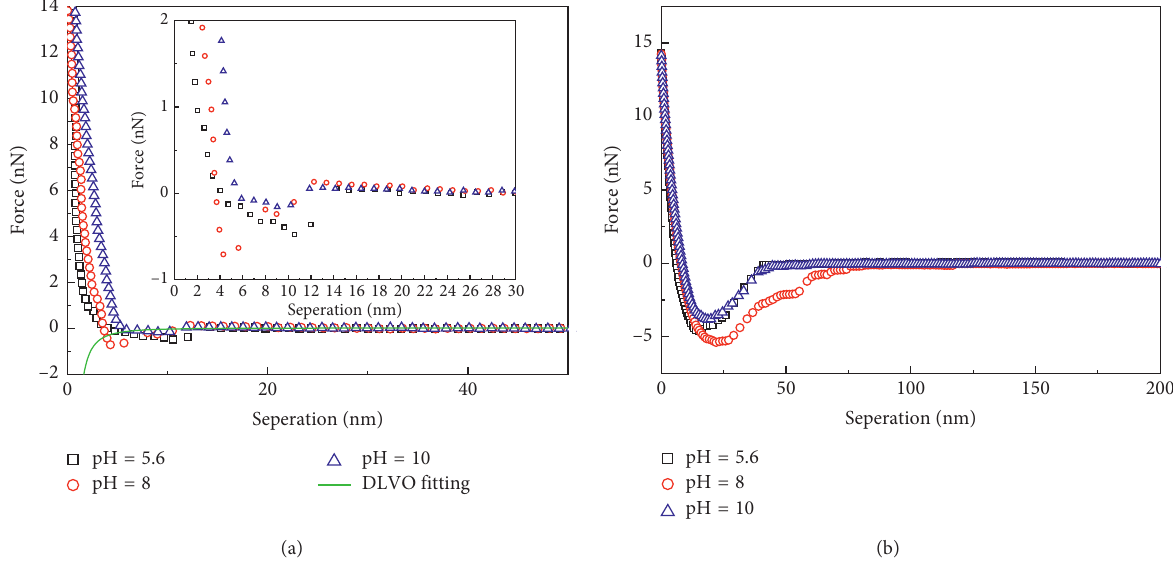
Figure 15: The interaction forces between scheelite particle and calcite substrate in ultrapure water solution: (a) approach curves; (b) retraction